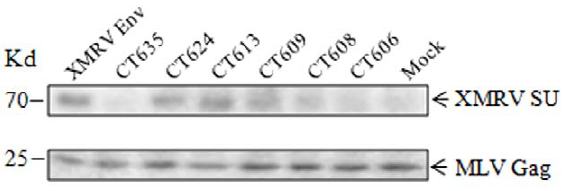
Figure 7. XMRV Env incorporations into an MLV retroviral vector. 293/GP_LAPSN cells were transfected with an XMRV Env- encoding plasmid, and viral particles were purified through ultracen- trifugation. Concentrated viruses were subjected to Western blot using an anti-FLAG antibody to detect XMRV SU (upper panel) or an anti-MLV gag antibody to examine MLV Gag (lower panel).